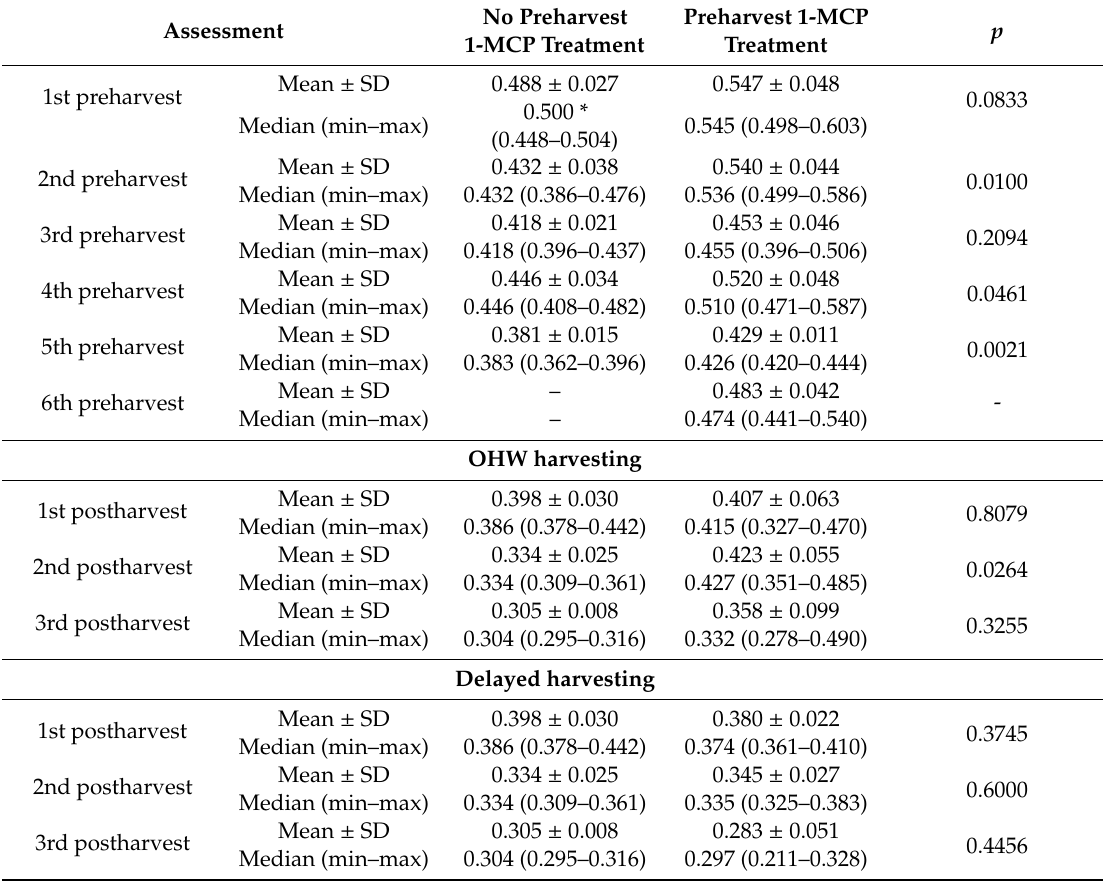
Table 4. Results for titratable acidity measured in ‘Szampion’ cultivar apples in the pre- and postharvest periods, compared for groups treated with 1-MCP and a control group not treated with 1-MCP.